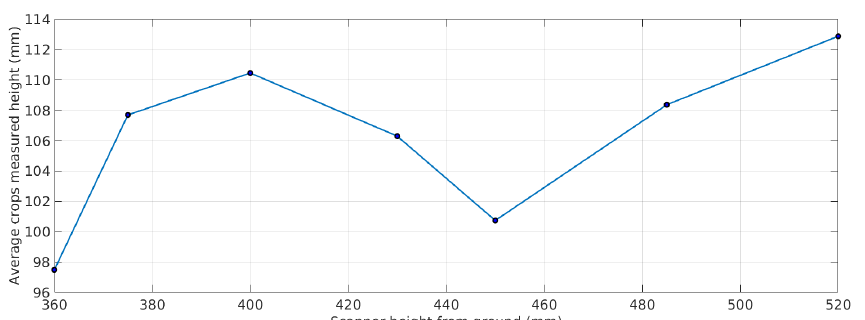
Figure 13. Scanning results.Mean measured height vs ToF sensor